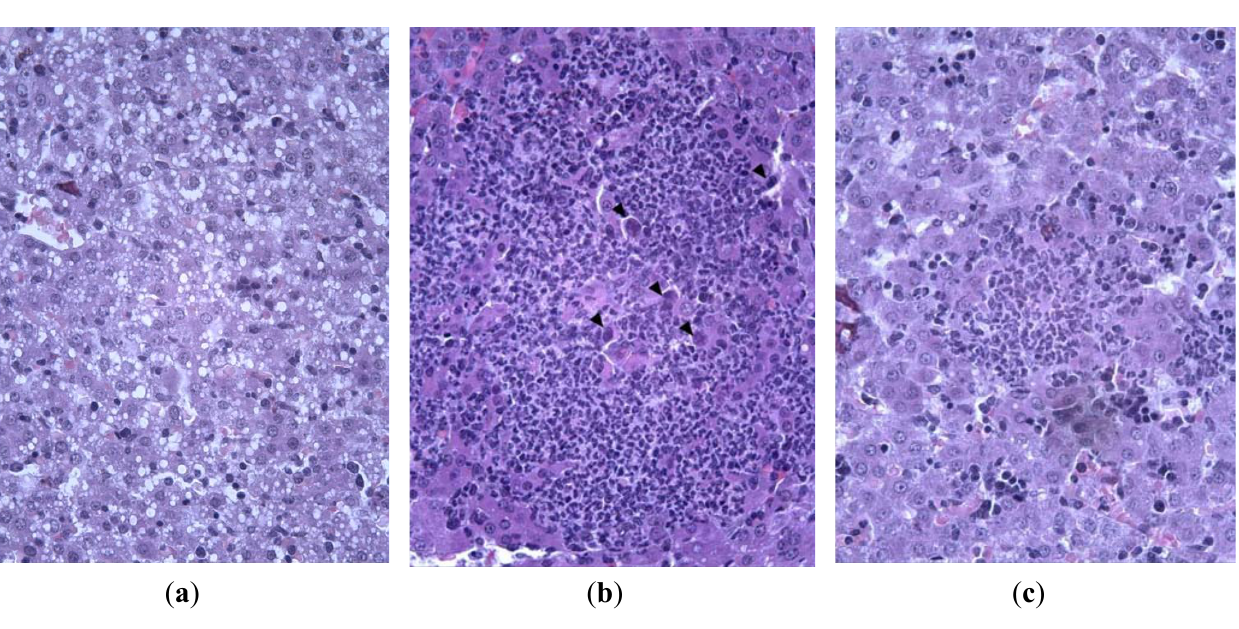
Figure 6. Pathology of AdV-induced hepatitis in the liver of newborn Syrian hamsters on day 3 p.i. Large focus of inflammation with numerous AdV-infected cells (arrowheads), vacuolization of hepatocytes ( a , b ) in control animals, small focus of inflammation and intact parenchyma ( c ) in Ingavirin-treated animals. Hematoxylin-eosin, ×400.